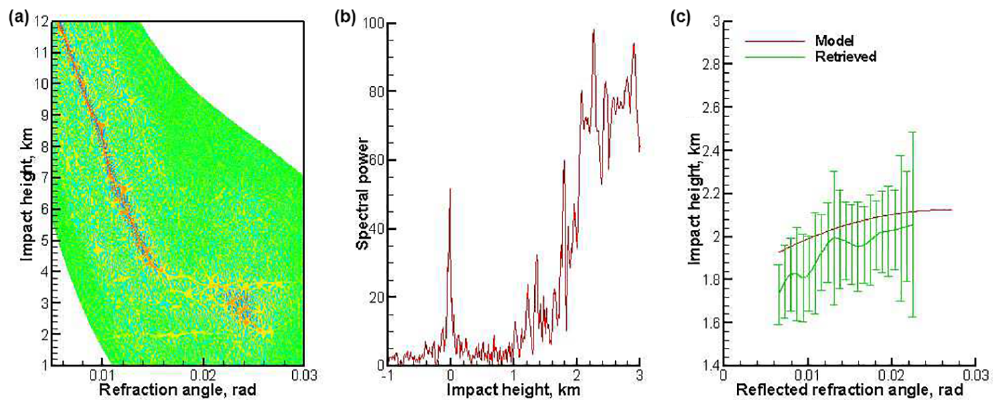
Figure 11. Occultation event 1 January 2008, 10:07:11UTC, 48.68 ◦ S 134.46 ◦ W. Expressed as a: (a) Wigner distribution function; (b) radio holographic spectrum; (c) model and retrieved reflection bending angles, the latter with error bars indicating the uncertainty estimate. Reflection index 13.6.